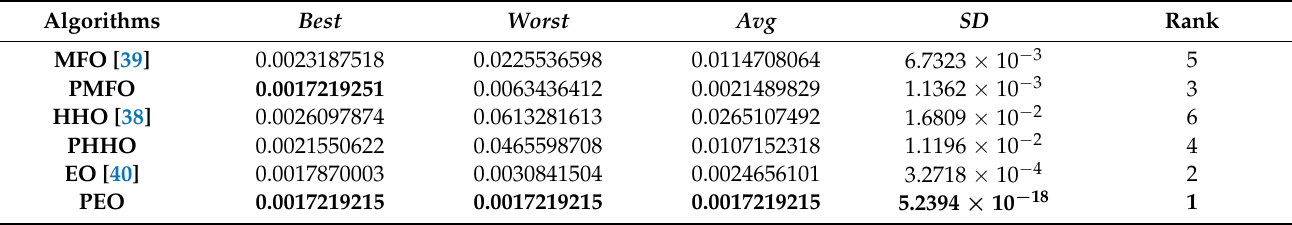
Bold results are the best